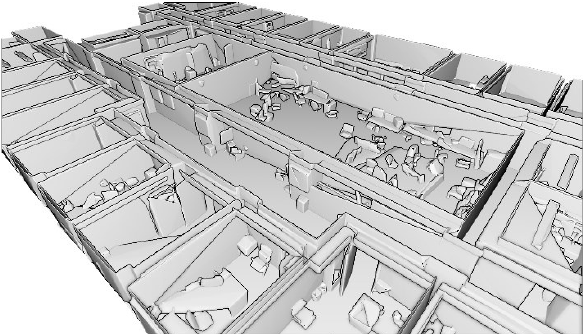
Figure 11 Example of an .obj file automatically created from the segmentation results Finally, the unsupervised segmentation and supervised classification is easily extensible by limiting